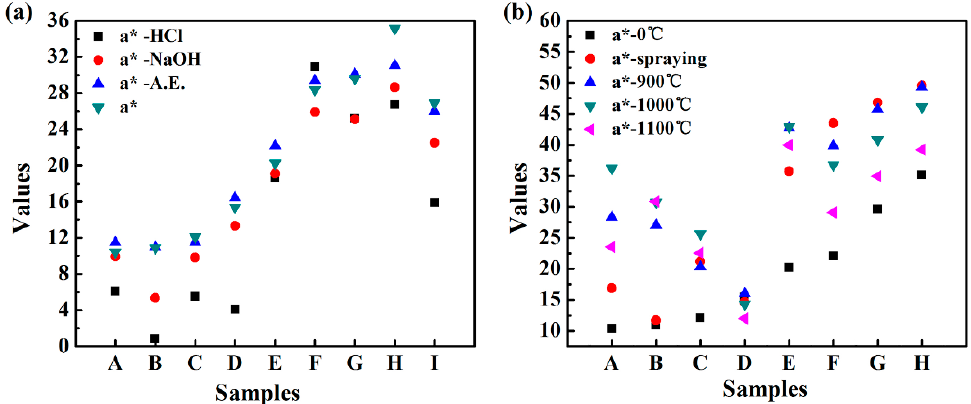
Figure 8. a* -value of iron red hybrid pigments after treatment under different conditions: ( a ) different chemical environments and ( b ) calcined coating at high temperature (A: IS-IOR, B: REC-IOR, C: KAO-IOR, D: MMT-IOR, E: VMT-IOR, F: SEP-IOR, G: HYS-IOR, H: ILL-IOR, I: COM-IOR).